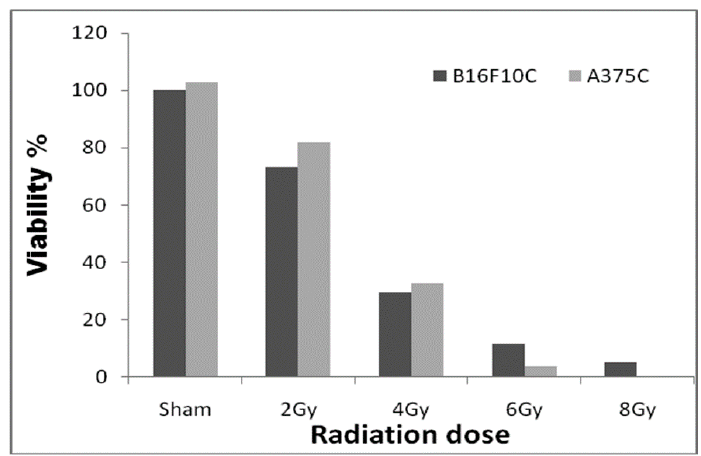
Figure 1. Radiation dose optimization with A375C and B16F10C cell lines. Cells were grown in T-25 flask and irradiated with 2, 4, 6, and 8 Gy gamma radiation (GC-5000, BRIT Mumbai) at the CARRT, Mangalore University, dose rate of 8.8 Gy/min at room temperature. After irradiation, cells were further incubated with drugs for 24 h. Sham served as untreated control. The dark bars represent mouse melanoma B16F10 cells and the light bars human melanoma A375 cells. The radiation dose optimization was performed only once. Therefore, it does not have an error bar.